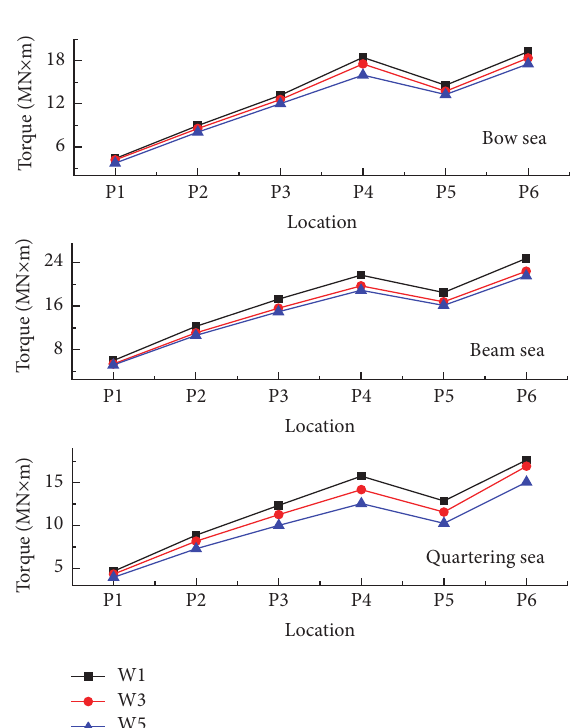
Figure 30: Longitudinal distribution of